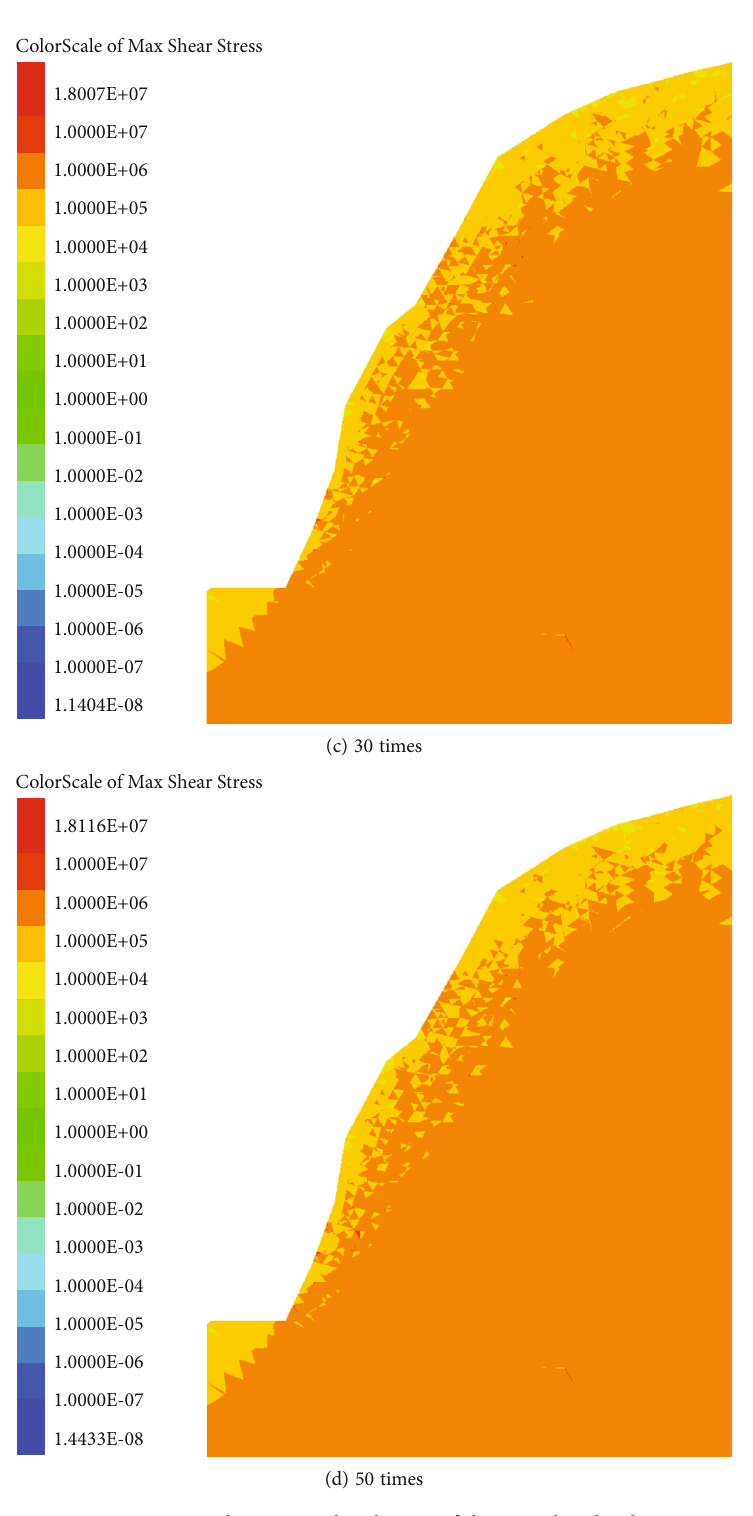
Figure 3: Max-shear stress distribution of the typical rocky